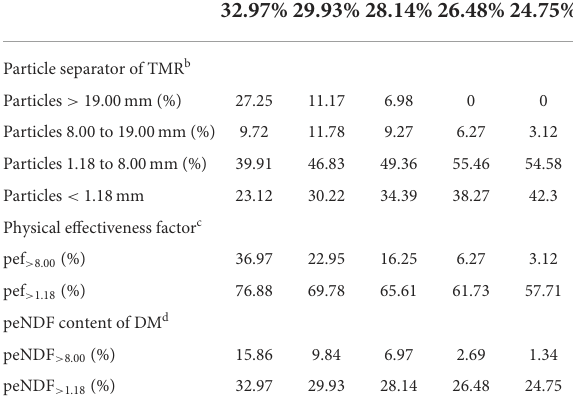
TABLE 2 Particle size distribution, physical effectiveness factors, and physically effective neutral detergent fiber content of the treatment rations fed to goats (DM